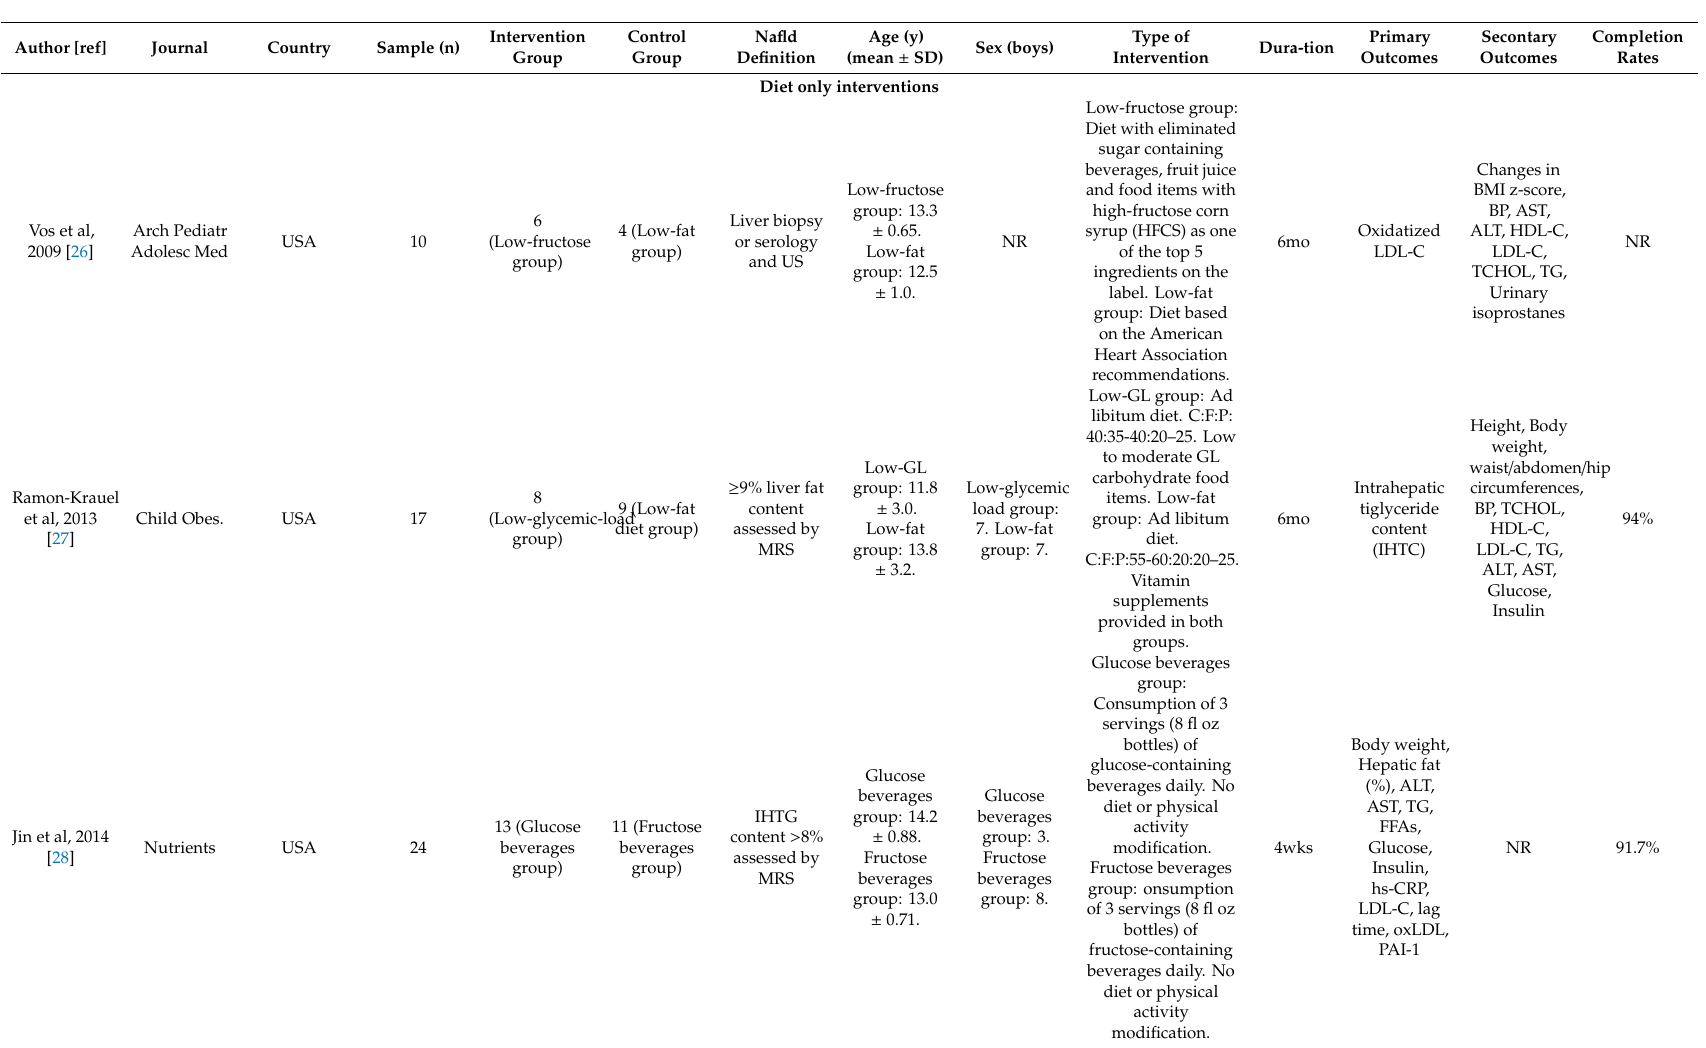
Table 1. Characteristic of interventions based on